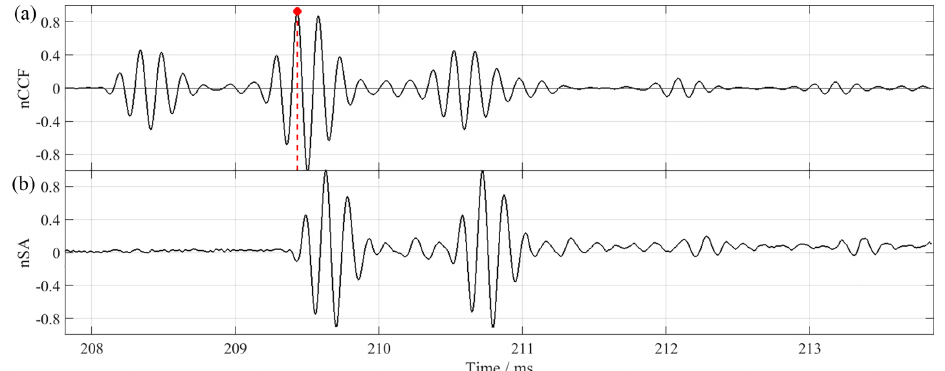
Figure 5. Example of a received acoustic signal (normalized signal amplitude, nSA, b ; distance of source and receiver: 70.45m) and corre- sponding normalized cross-correlation function (nCCF, a ) between the received and the generated signal. The maximum position of nCCF is marked with a filled (red) point. The associated time lag corresponds to the travel time of the